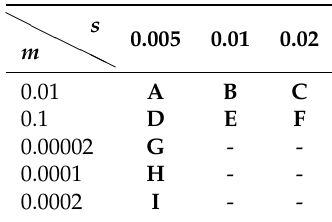
Table 2. The nine parameter combinations presented, and the corresponding figure panels, as denoted by letters, in Figures 4 and 5. Fifty replicates of each noted combination were used. “-” means that results were not generated for the given